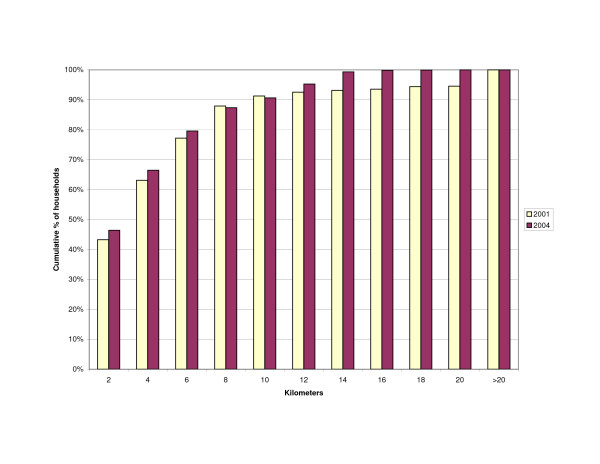
Cumulative percentage of households within given distance to nearest drug store.